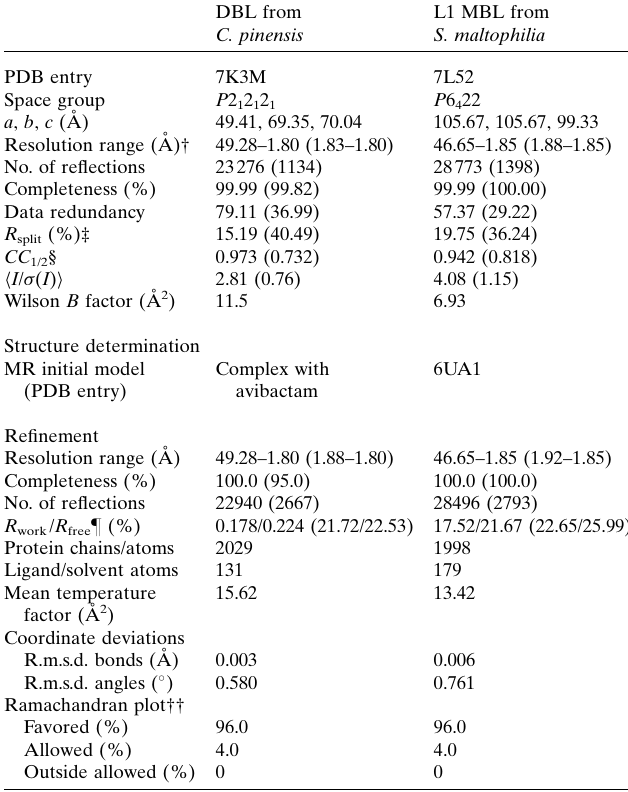
Table 2 Data collection and structure refinement